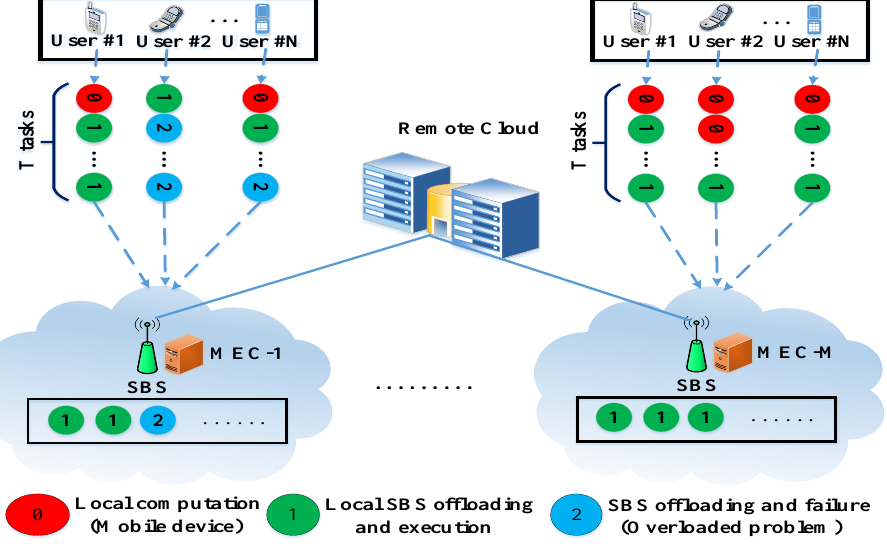
Figure 2. Multi-server multi-user MEC